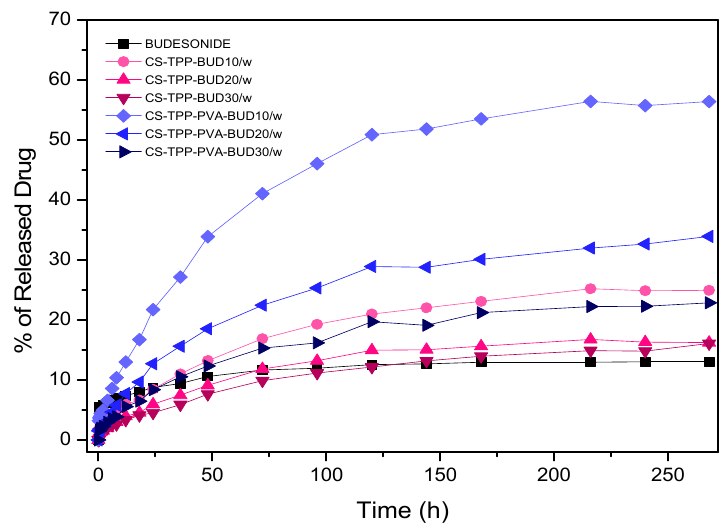
Figure 11. In vitro release of BUD from CS nanoparticles at pH 7.4.